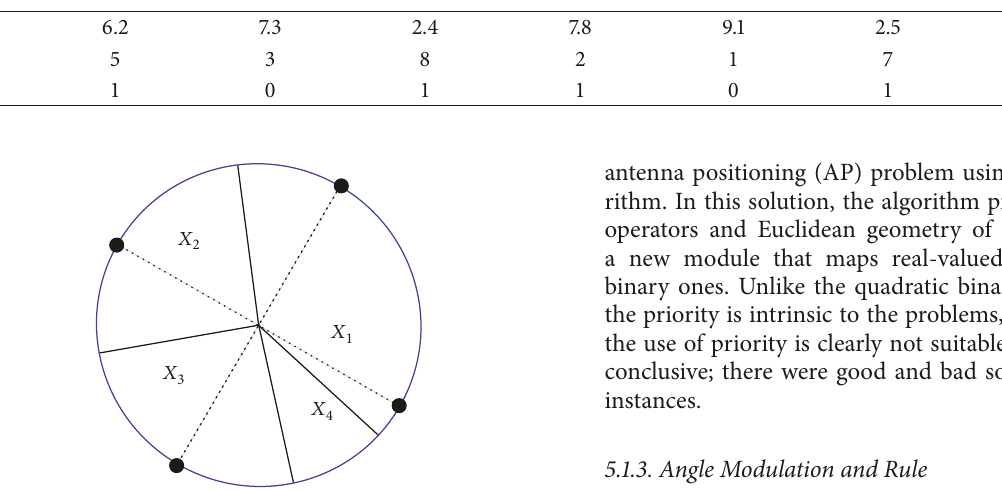
Table 2: The vector 𝑋 corresponds to a continuous solution, the vector 𝐼 is the great value position, and 𝐵 is the result of the binarization rule.